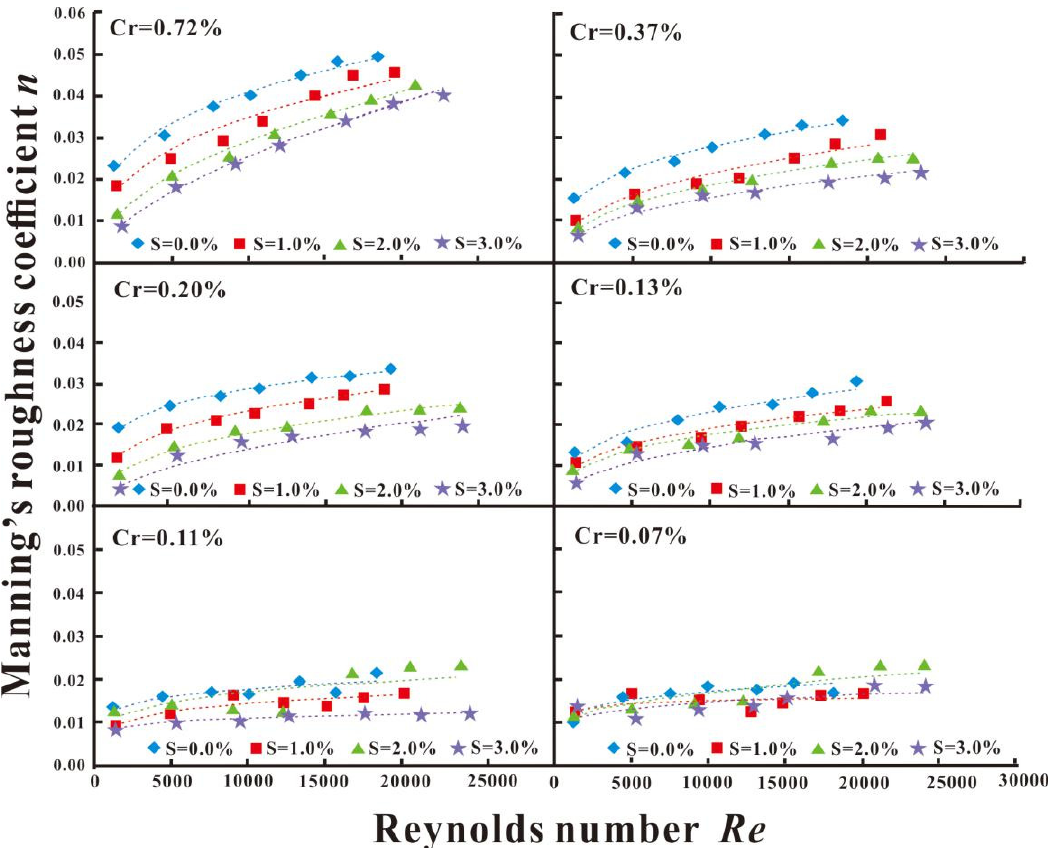
Figure 4. Manning’s roughness coefficient ( n ) for different combinations of Reynolds number ( Re ), stem cover ( Cr ) and slope gradient ( S ). Stem cover range: 0.72, 0.37, 0.20, 0.13, 0.11, 0.07%; slope gradient range: 0, 1.0, 2.0, 3.0%.